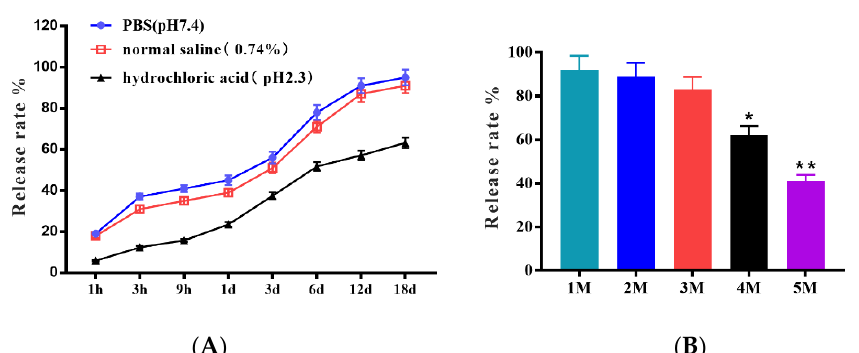
Figure 1. The stability of microcapsules shown by the release rate in ( A ) PBS, normal saline, hydrochloric acid, and release ability in different months ( B ). The differences between means were considered significant at * p < 0.05 and very significant at ** p < 0.01.